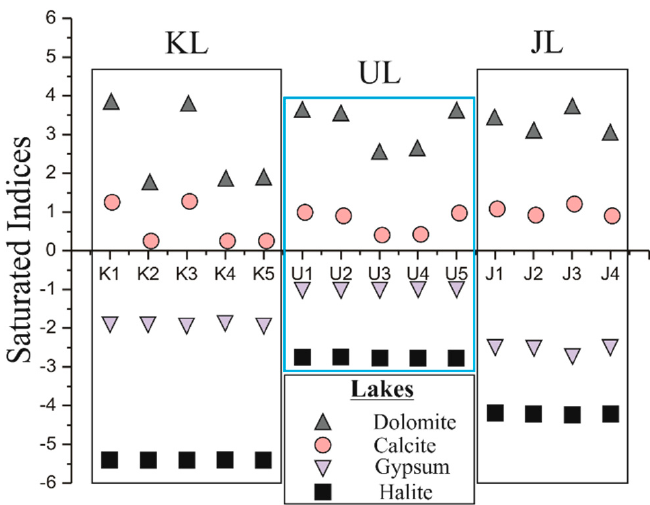
Figure 6. Saturation indices calculated for the following dissolved minerals: dolomite, calcite, gypsum and halite.